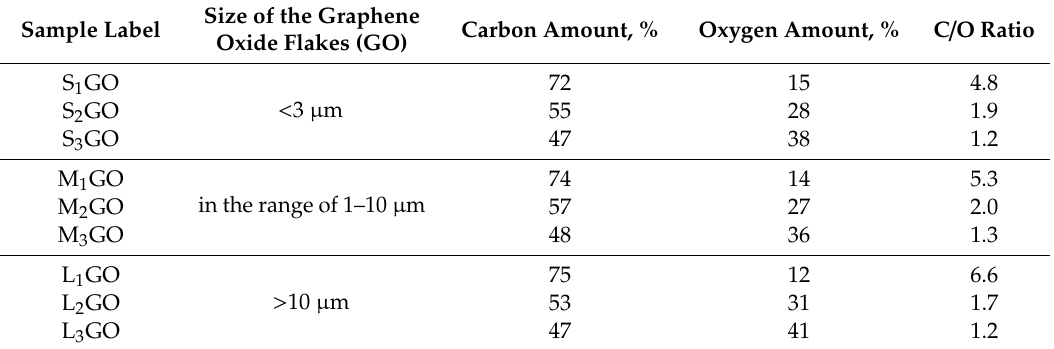
Table 1. Labeling of the examined samples of graphene oxide powder (GO). S, M, and L GO flakes are, respectively, below 3 µ m; in the range of 1–10 µ m; larger than 10 µ m. The lower index (1, 2, and 3) next to the letter indicates the oxidation degree of the material, respectively: low, medium and